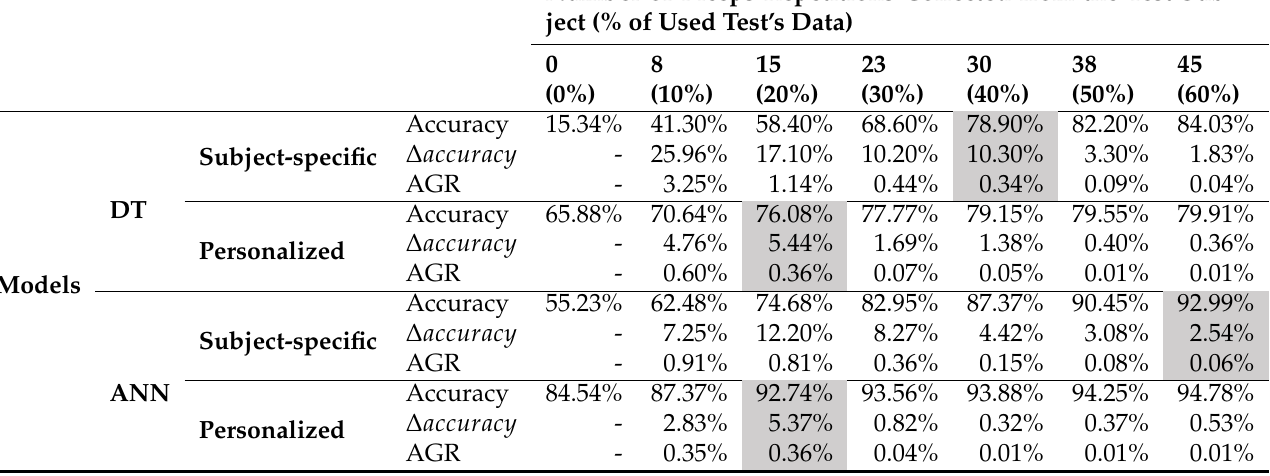
Table 5. The accuracy averages for the subject-specific and personalized models after adding 10% of the test subject’s data to the training set in each run incrementally. We include a version of this table with the confidence intervals in the Appendix